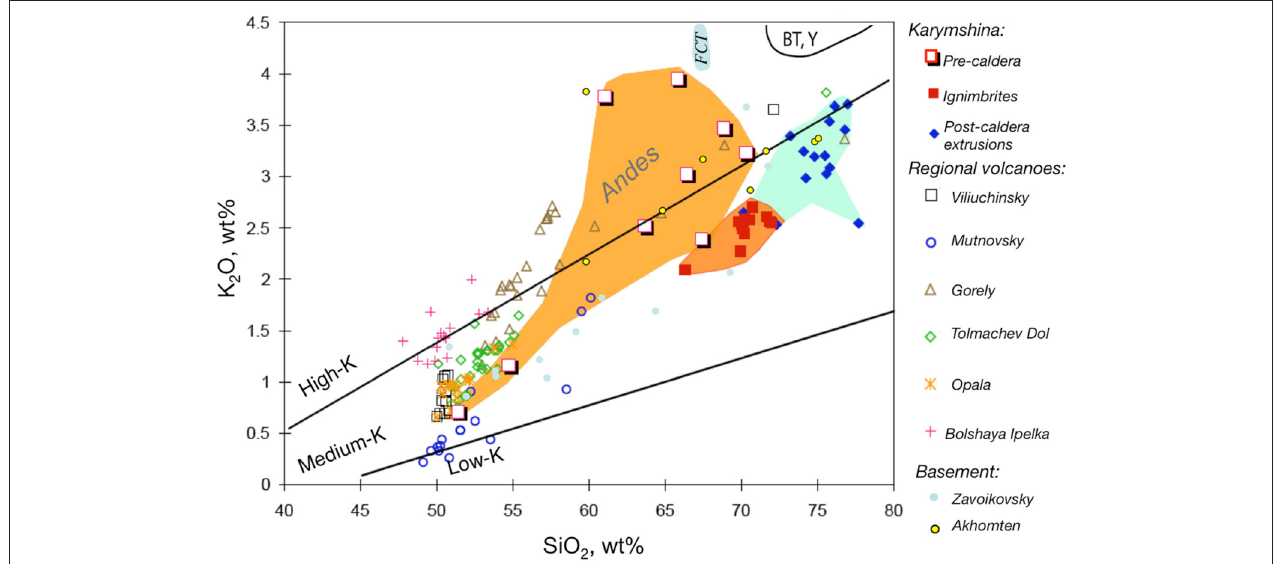
FIGURE 5 | K 2 O-SiO 2 graph for Karymshina Volcanic Complex magmas and neighboring volcanoes. Central Andean magma compositional field is from Hildreth and Moorbath (1988) . FCT, BT, and Y are ranges in the Fish Canyon tuff, Bishop tuff, and Yellowstone tuffs of western N America respectively, see Figure 1 for caldera outline